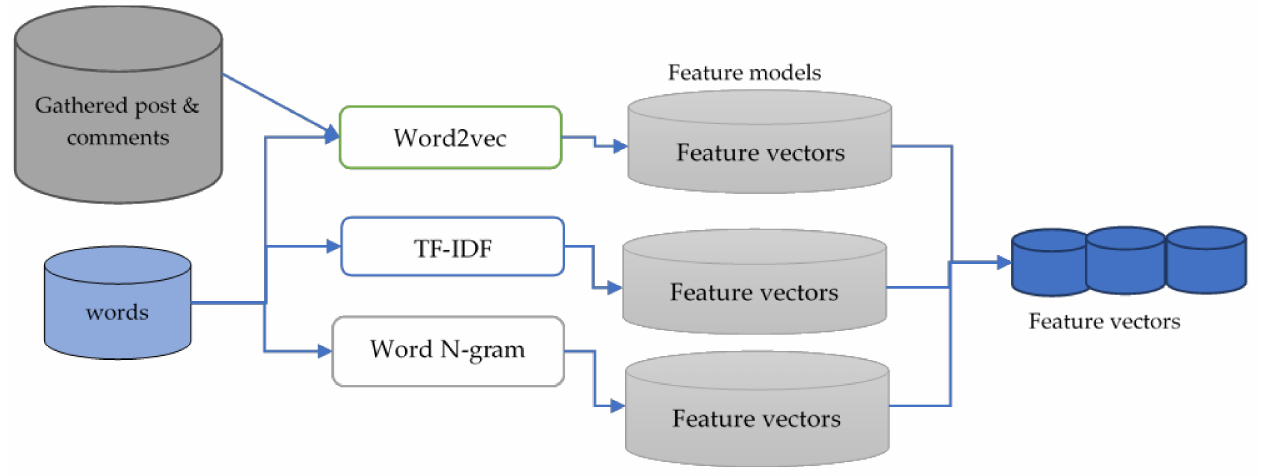
Figure 3. The feature extraction flow